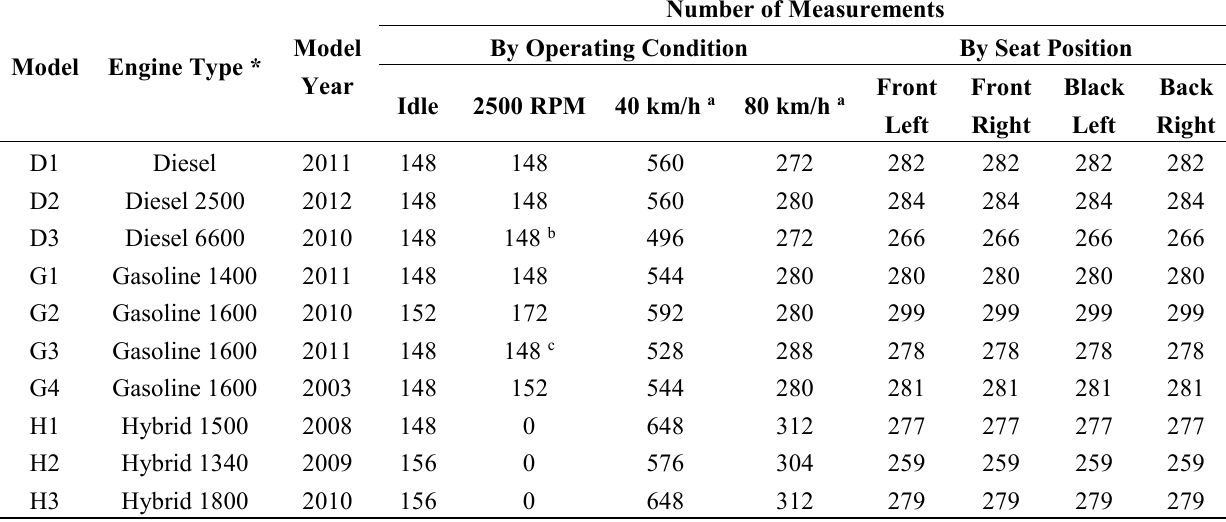
Table 1. Car types and number of continuous measurements by operating condition and seat position.